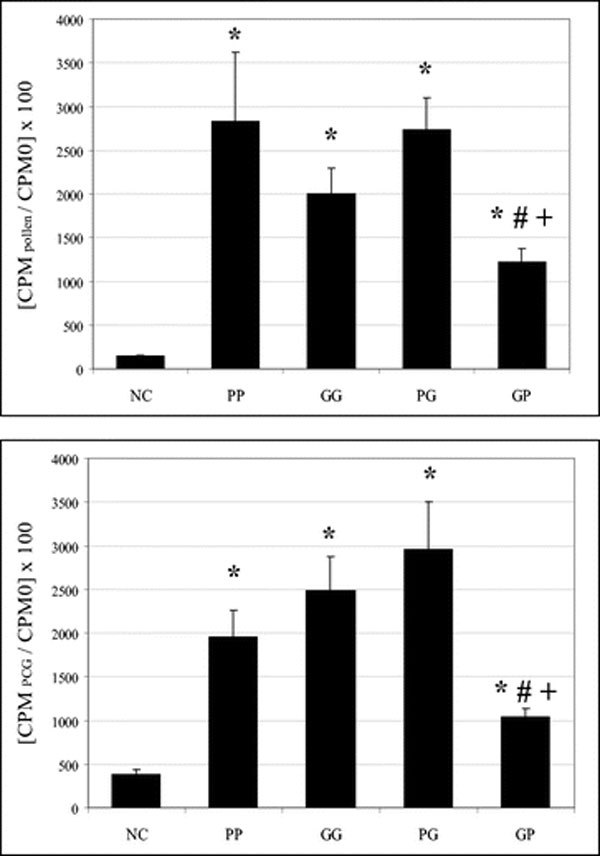
Pollen and PCGs-induced proliferation of lymph node cells. Cells from the NC and the 4 sensitized rats' groups were cultured with [3H]-thymidine in the presence of 100 μg of pollen and 9 × 106 PCGs. cpmpollen, thymidine incorporation by pollen-stimulated cells; cpmPCGs, thymidine incorporation by PCGs-stimulated cells; cpm0, thymidine in-corporation in control cells; NC, negative control group; PP, rats sensitized and challenged with 0.5 mg of pollen; GG, rats sensitized and challenged with 4.5 ×107 PCGs; PG, rats sensitized with 0.5 mg of pollen and challenged with 4.5 × 107 PCGs; GP, rats sensitized with 4.5 × 107 PCGs and challenged with 0.5 mg of pollen; *, significantly different from the NC group (P < 0.05); #, significantly different from the PP group (P < 0.05); +, significantly different from the GG group (P < 0.05).